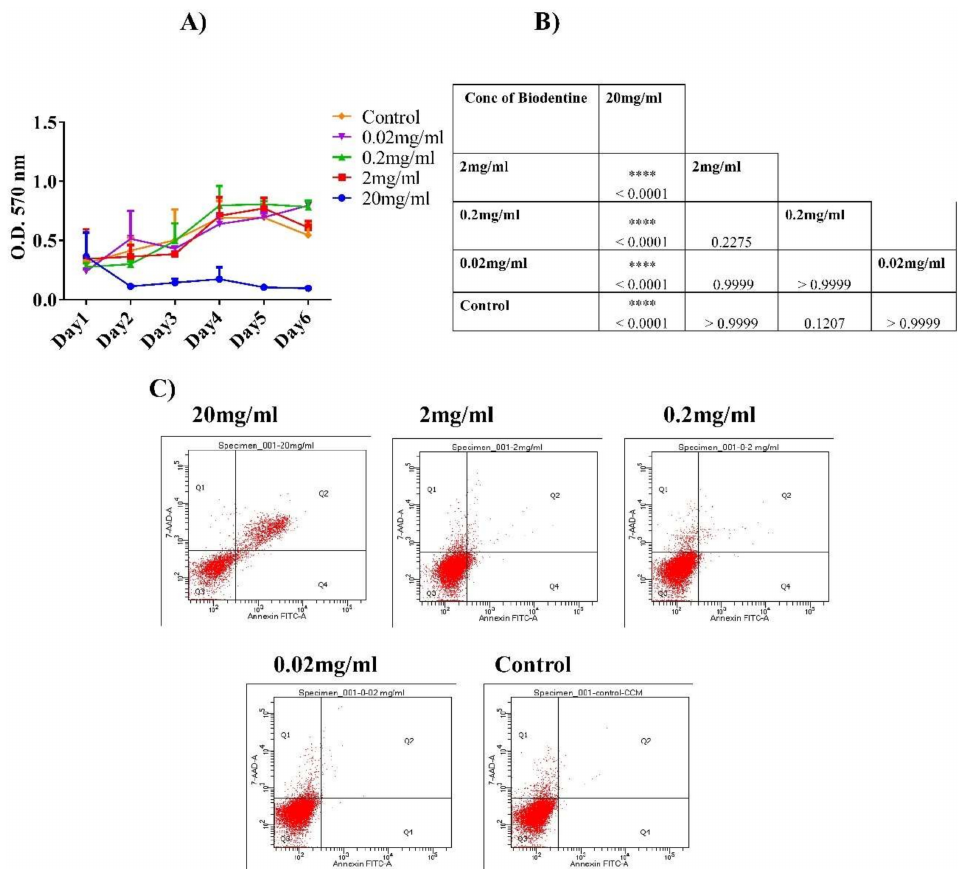
Figure 1. Cell proliferation and cytotoxicity of human periodontal ligament stem cells hPDLSCS treated with Biodentine ™ . ( A ) Cell proliferation (MTT) assay of hPDLSCs treated with di ff erent concentrations of Biodentine ™ (20, 2, 0.2, 0.02 mg / mL) and blank control. ( B ) A representative table showing the statistical di ff erences among all concentrations for 6 days of MTT assay Biodentine ™ ( p < 0.05). ( C ) Flow cytometric analysis of hPDLSCs stained with Annexin V / 7AAD stain. The four quadrants of dot plot indicate the percentage of: necrotic cells (Q1), late apoptotic cells (Q2), viable cells (Q3) and early apoptotic cells (Q4). (**** p < 0.00005, *** p < 0.0005, ** p < 0.005, * p <